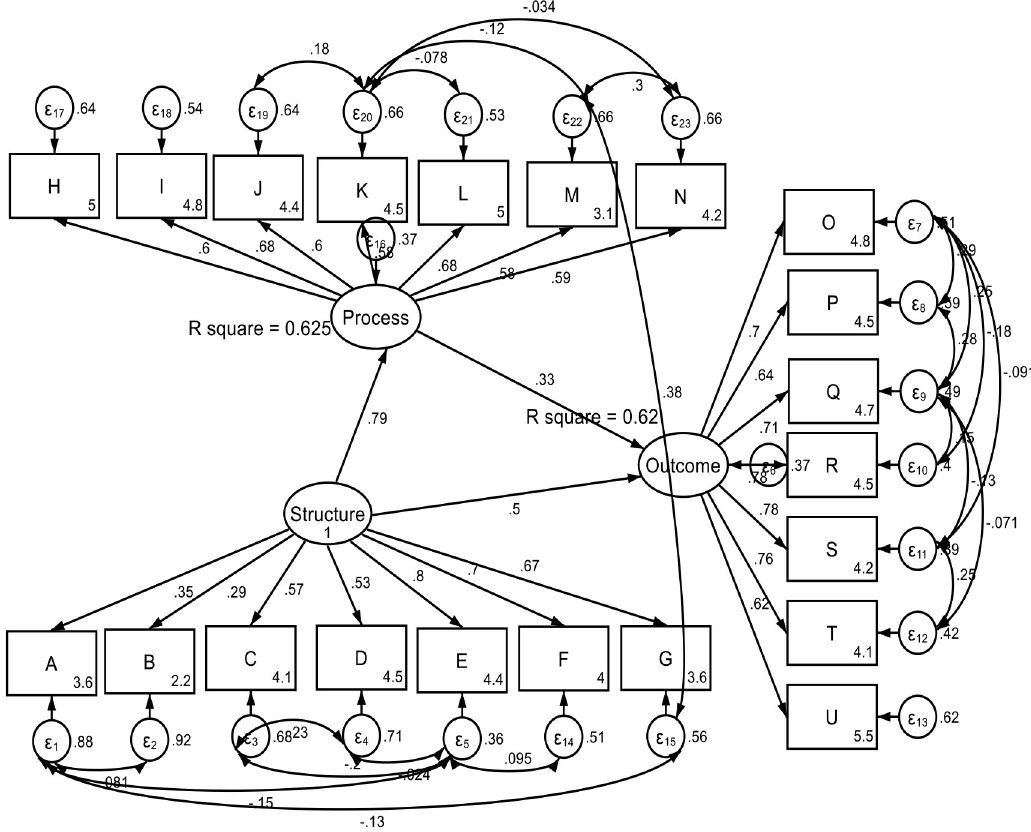
Fig 2. Standardized coefficient estimates of hypothesized